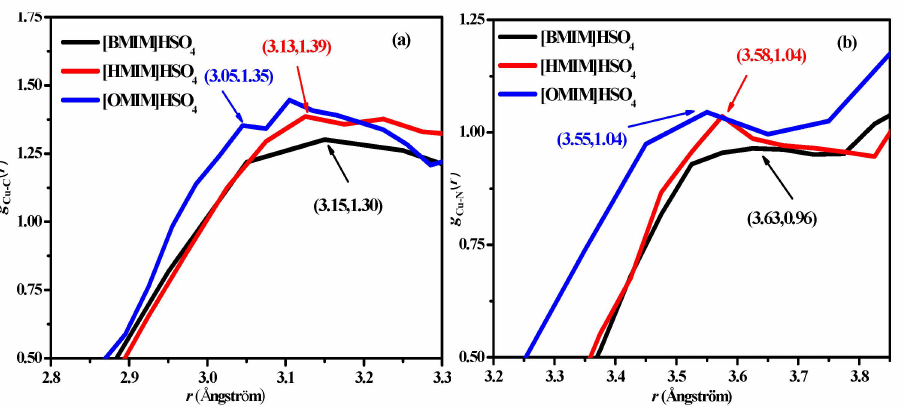
Figure 7. Radial distribution functions of Cu atoms and the C2, N atom in the imidazolium ring of ILs in sulfuric acid from MD simulation. ( a ) RDF g Cu-C ( r ) of Cu atoms and the C2 atom of ILs, ( b ) RDF g Cu-N ( r ) of Cu atoms and the N atom of ILs.